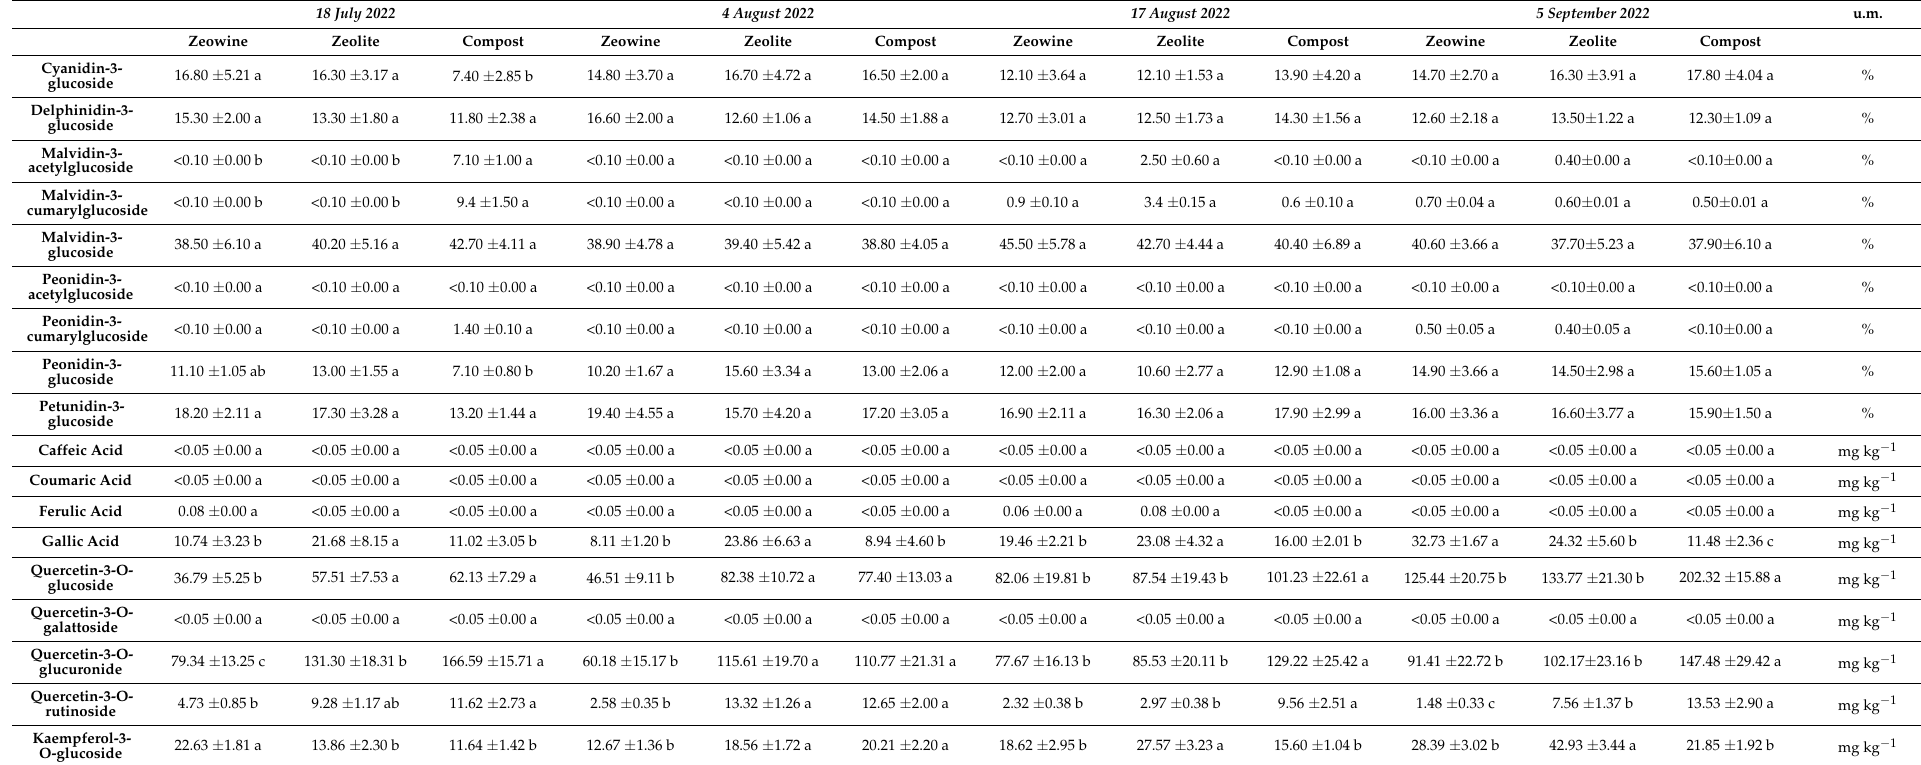
Table 2. Phenolic maturity. Fractionation of anthocyanins (Cyanidin-3-glucoside, Delphinidin-3-glucoside, Malvidin-3-acetylglucoside, Malvidin-3-cumarylglucoside, Malvidin-3-glucoside, Peonidin-3-acetylglucoside, Peonidin-3-cumarylglucoside, Peonidin-3-glucoside, and Petunidin-3-glucoside) and Coumaric Acid, Gallic Acid, Caffeic Acid, Ferulic Acid, Kaempferol-3-O-glucoside, Quercetin-3-O-glucoside, Quercetin-3-O-rutinoside, Quercetin-3-O-galactoside, and Quercetin-3O-glucuronide of Vitis vinifera treated with Zeowine, zeolite, and compost during the 2022 season. Measurements were conducted four times: full veraison (18 July 2022), mid-maturation (4 August 2022), full maturation (17 August 2022), and harvest (5 September 2022). Data (mean ± SE, n = 10) were subjected to one-way ANOVA. Different letters indicate significant differences between Zeowine, Zeolite, and Compost (LSD test, p ≤ 0.05). 18July2022 4August2022 17August2022 5September2022